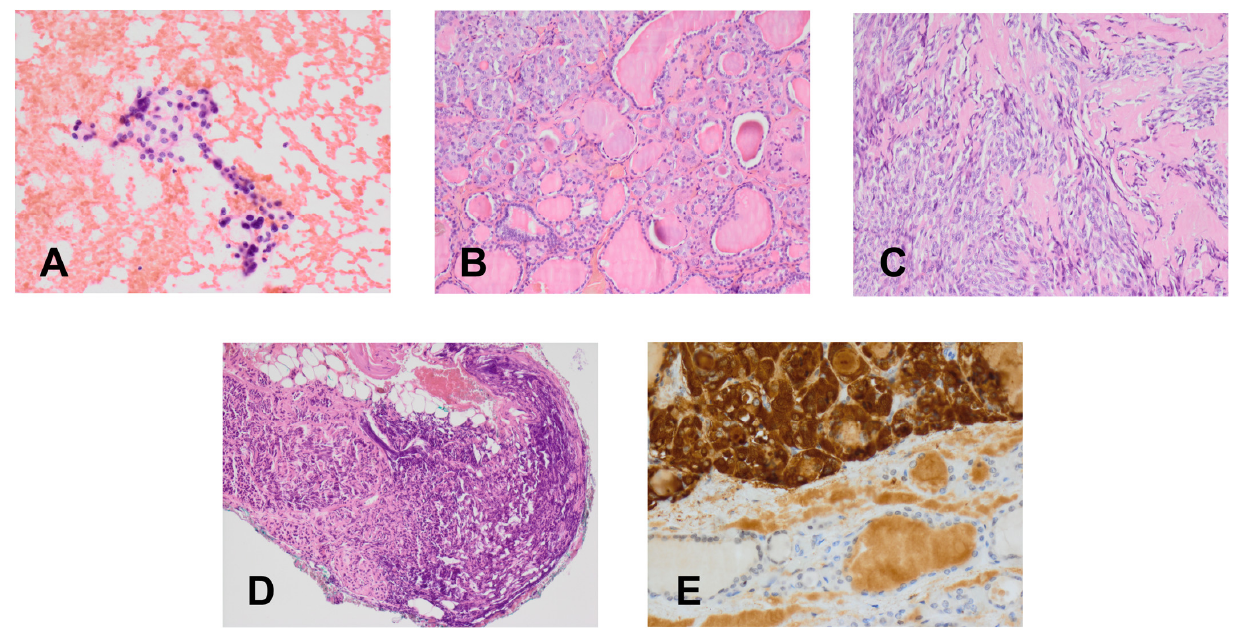
Figure 4. Cytological and histological (H&E) findings (×400). ( A ) Fine-needle aspirate with medullary thyroid cancer. ( B ) Primary C-cell hyperplasia in the patient’s isthmus. ( C ) Medullary thyroid cancer in a thyroid nodule. ( D ) Metastasis of medullary thyroid cancer in a cervical lymph node. ( E ) Immunohistochemistry for calcitonin in a medullary thyroid cancer.